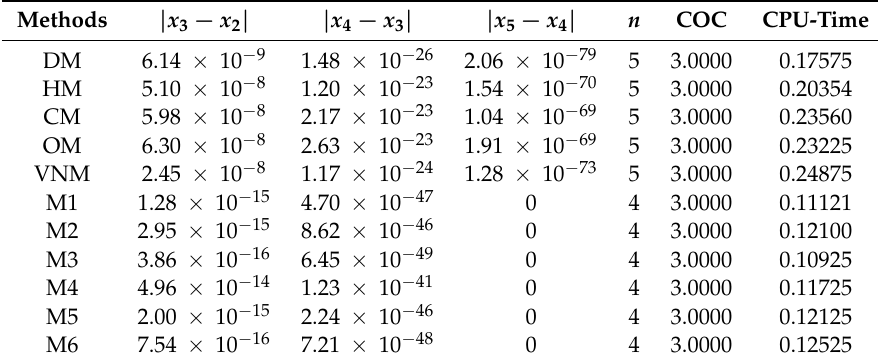
Table 2. Comparison of performance of methods for Example 2.